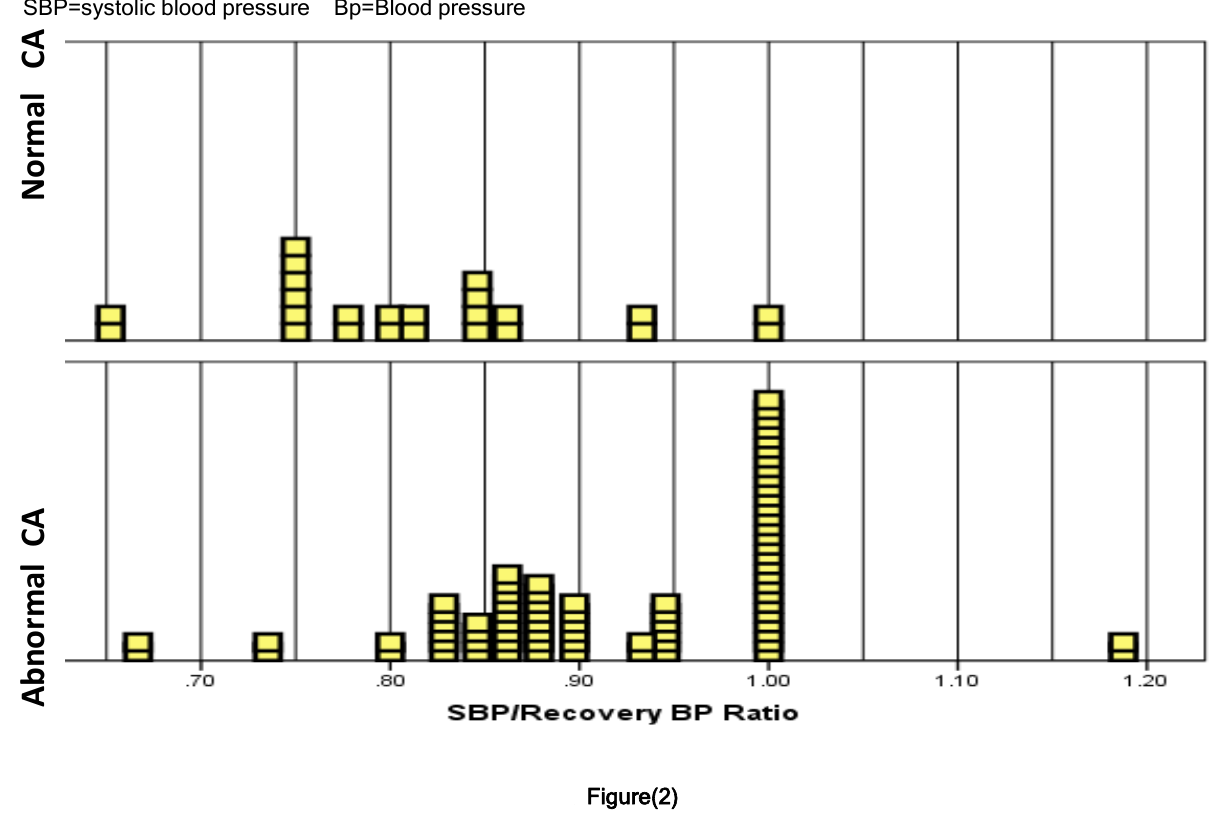
Distribution of SBP/recovery blood pressure ratio in normal and abnormal coronary angiography CA=CORONARY